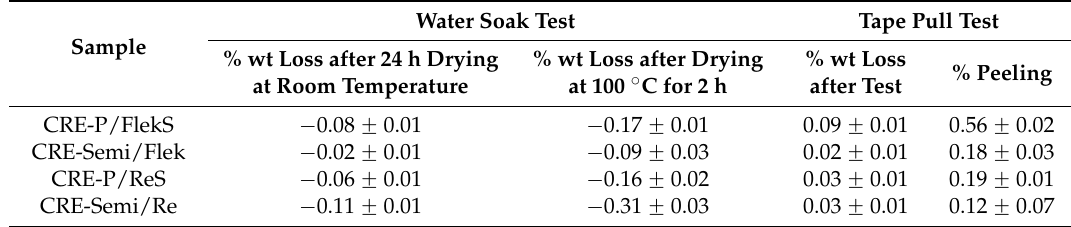
Table 4. The weight loss (wt %) after the water soak test and tape pull